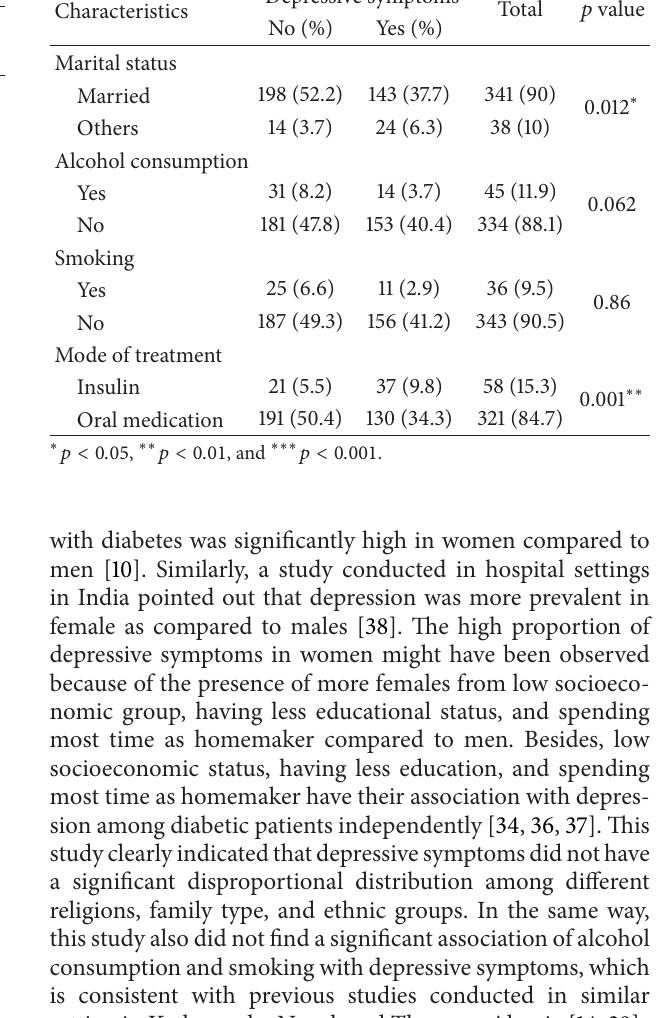
Table 3: Distribution of depressive symptoms by sociodemographic characteristics and behavior